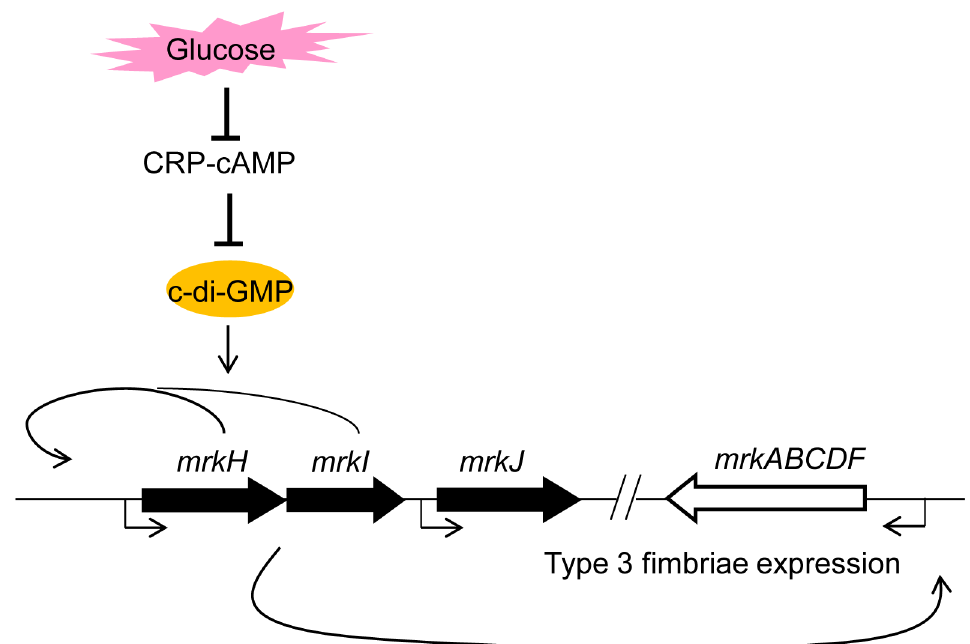
Fig 7. A proposed model for CRP-cAMP signaling pathway on type 3 fimbriae and MrkHI expressions in K . pneumoniae .